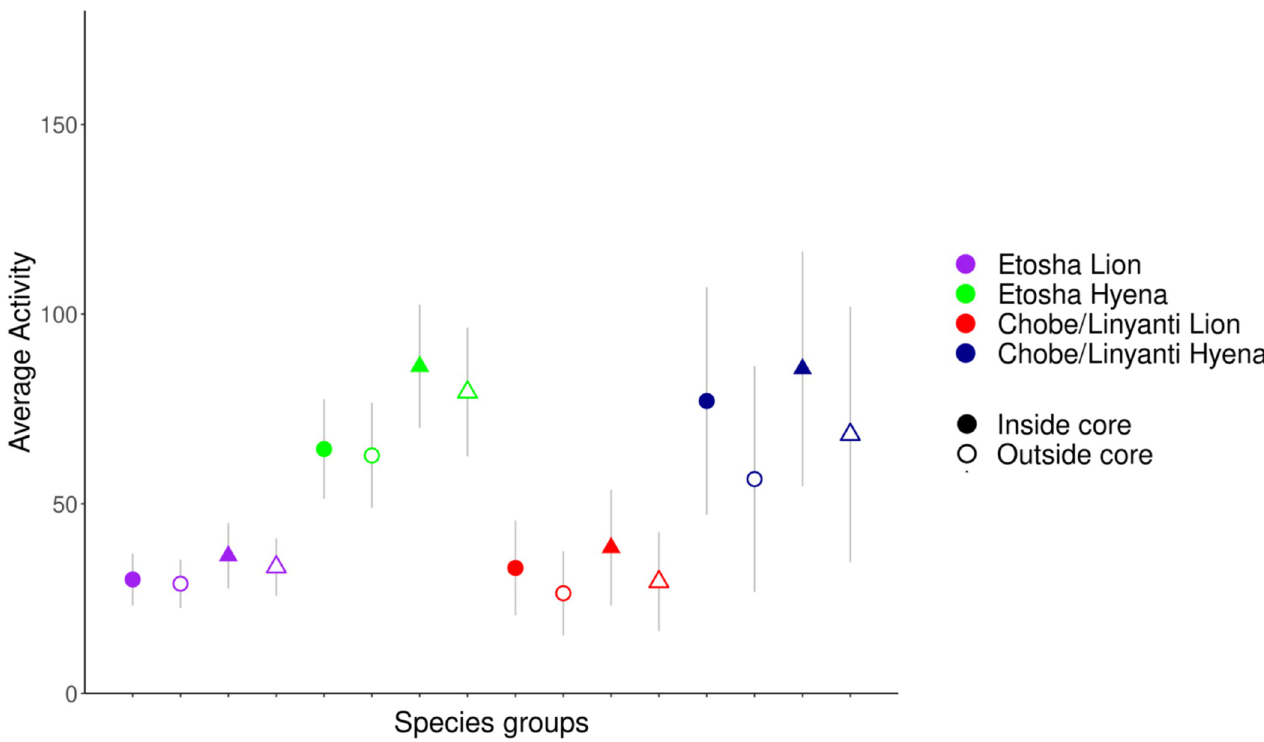
Fig 9. Average activity of lions and spotted hyenas with respect to competitor core use areas. Inside competitor core areas are represented by solid shapes, and outside competitor core areas are represented by open shapes. Shapes represent the mean activity and error bars the SE. Activity was measured simultaneously on each axis as the difference in acceleration between two consecutive measurements and given a relative range between 0 and 255 (activity monitor values [AMVs]), characterizing the mean activity/acceleration. Activity X (circles) = forward/backward motion. Activity Y (triangles) = rotary/ sideways